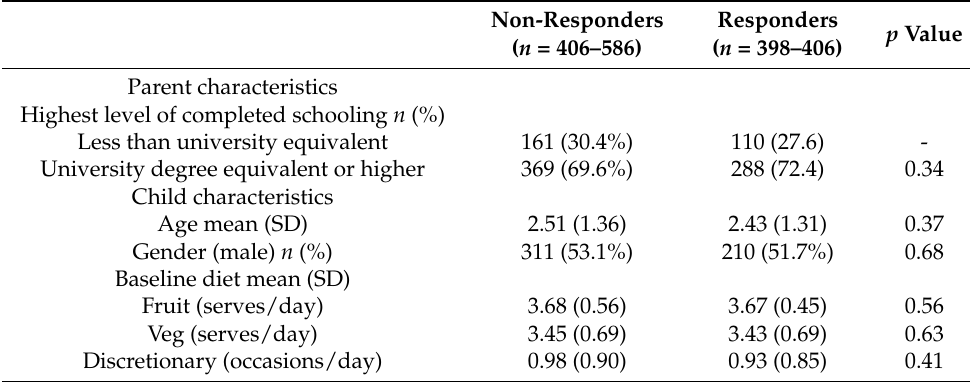
Table A1. Comparison of participant characteristics at baseline, between follow-up respondents and follow-up non-respondents.